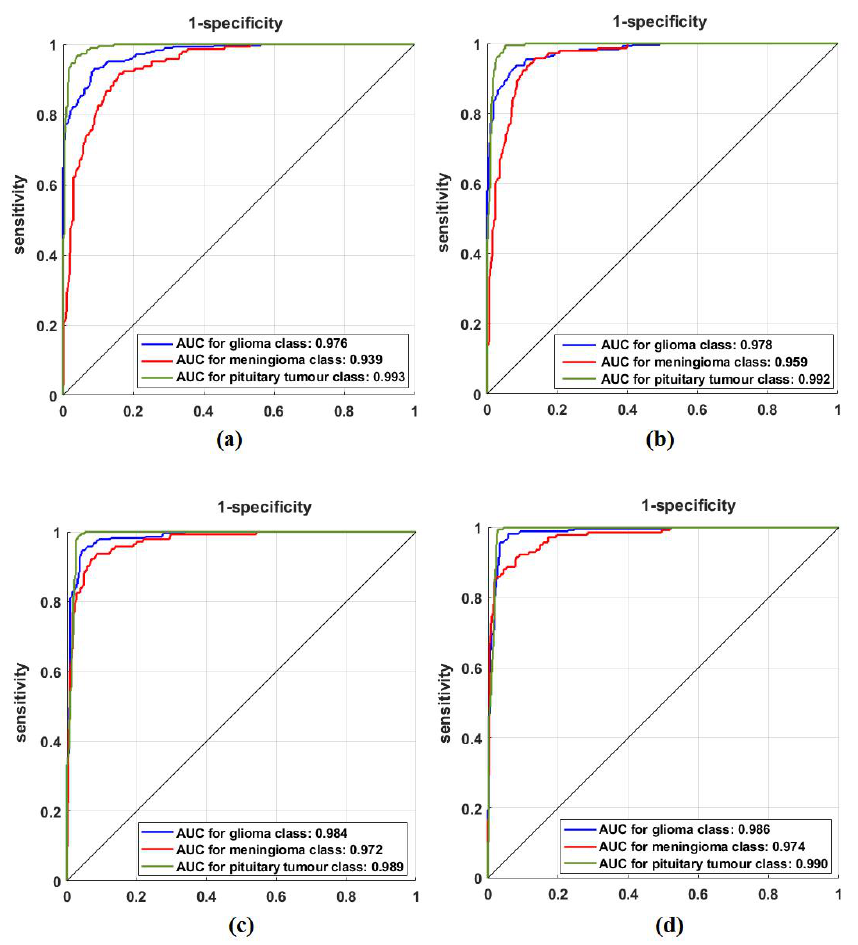
Figure 10. ROC analysis of the Brain tumour test set obtained by: ( a ) ResNet-50 pre-trained network, ( b ) DeTraC, ( c ) 4S-DT , and ( d ) XDecompo .